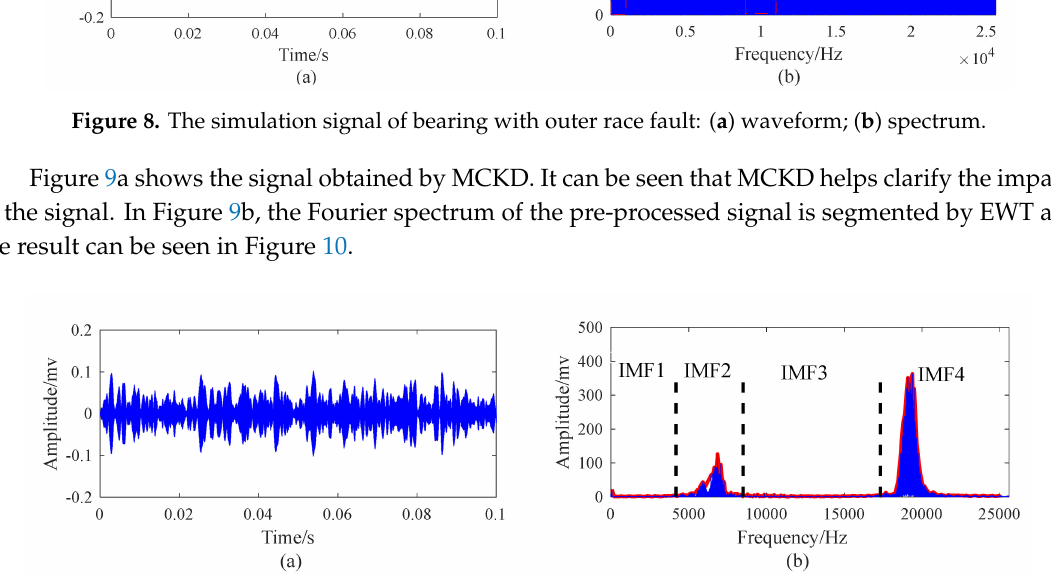
Figure 9. The result of the simulation signal of the bearing with outer race fault processed by the MCKD-EWT method: ( a ) waveform of signal processed by MCKD; ( b ) Fourier spectrum segmentation results of Improved EWT